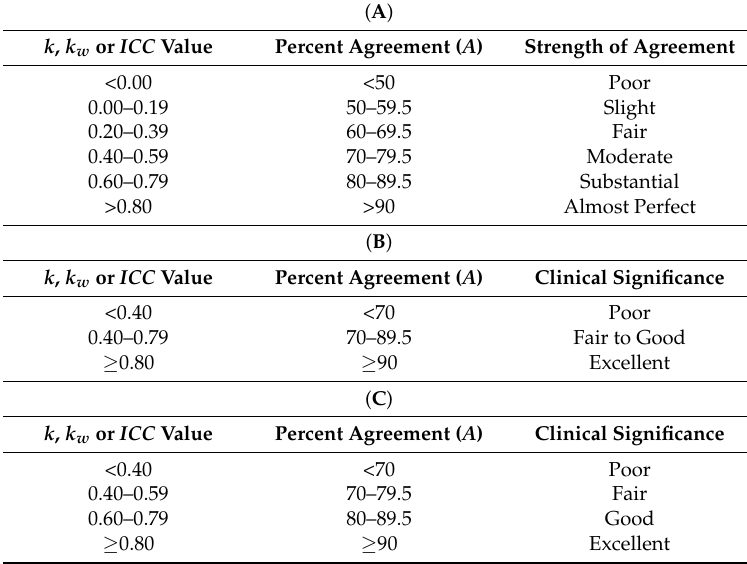
Table 3. ( A ) Revised Landis and Koch Criteria [8] for Assessing Enological Significance; ( B ) Revised Fleiss, Levin and Cho Paik (2003) Criteria for Assessing Enological Significance; ( C ) Revised Cicchetti (1994) Criteria for Assessing Enological